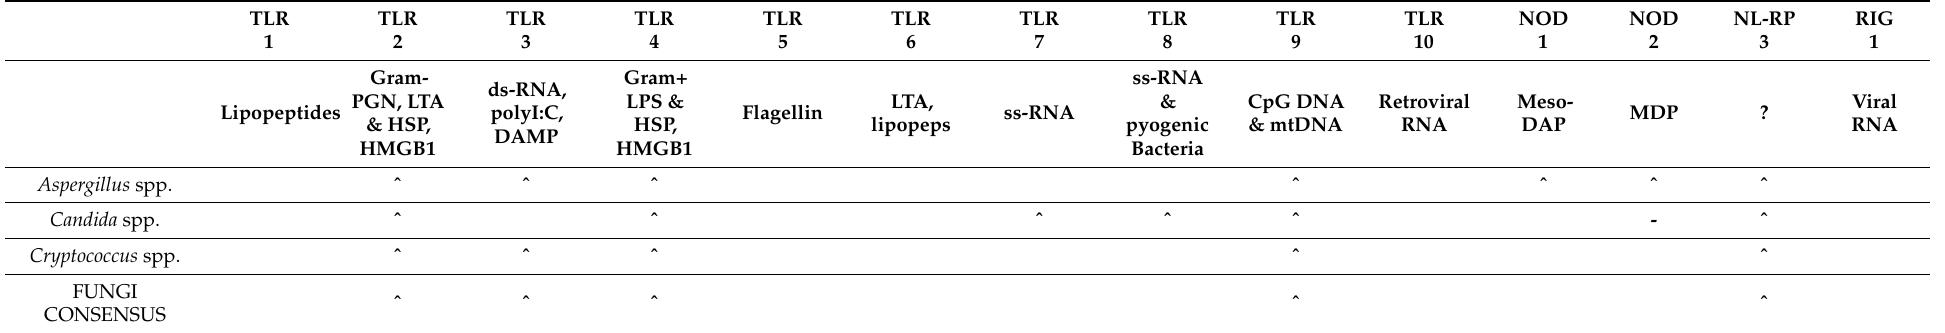
Table 4. Innate immune receptor activation by fungi associated with severe COVID-19. Spp. = species, – indicates no change, ˆ indicates increased activation or protein expression, V indicates downregulation or decreased protein expression, +/- indicates conflicting reports about whether there is increased activity or protein expression and a blank square indicated no available information. PGN = peptidoglycan; LTA = lymphotoxin alpha; HSP = heat shock protein; HMGB1 = High Mobility Group Box 1 protein; dsRNA = double-stranded ribonucleic acid; polyI:C = polymer composed of inosine and cytosine; DAMP = damage-associated proteins; Gram+ = expressed by Gram-positive bacteria; lipopeps = lipopolypeptides; ssRNA = single-stranded ribonucleic acids; CpG DNA = deoxyribonucleic acid high in cytosine and guanine, typifying a microbial genomic origin; mtDNA = deoxyribonucleic acid derived from mitochondria; DAP = diaminopimelic acid, a bacterial cell wall component; MDP = muramyl dipeptide, a bacterial cell wall component and ? = activators not presently known. TLR